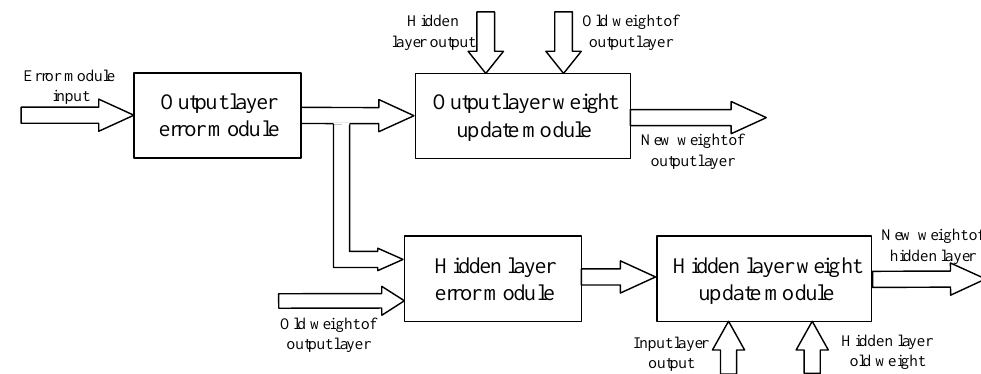
Figure 10. Structure design of backpropagation